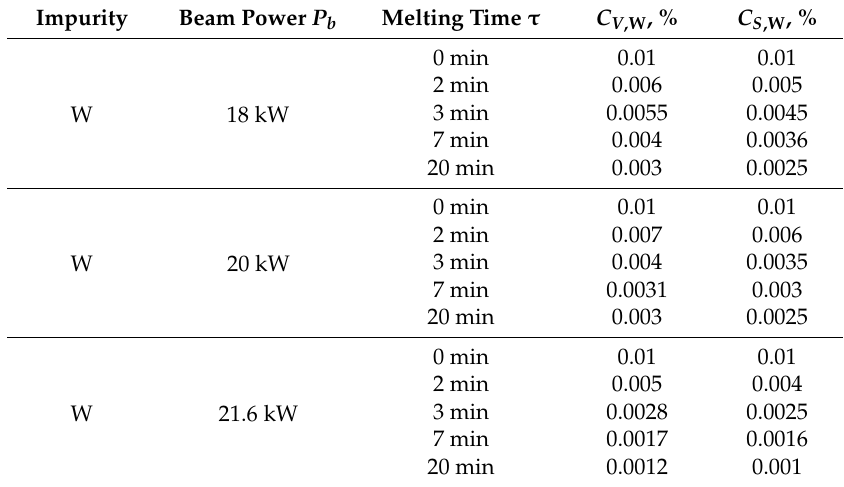
Table 4. Tungsten concentration in the molten volume ( C V ,W ) and at the top surface of the liquid pool ( C S ,W ) depending on the beam power and refining time of the EBM of